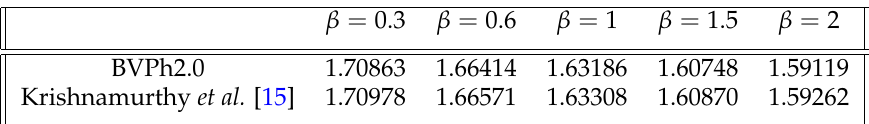
Table 4. Comparison between the present findings and those reported by Krishnamurthy et al. [15] for the values of - Re 1/2 x C f with λ → ∞ and N =